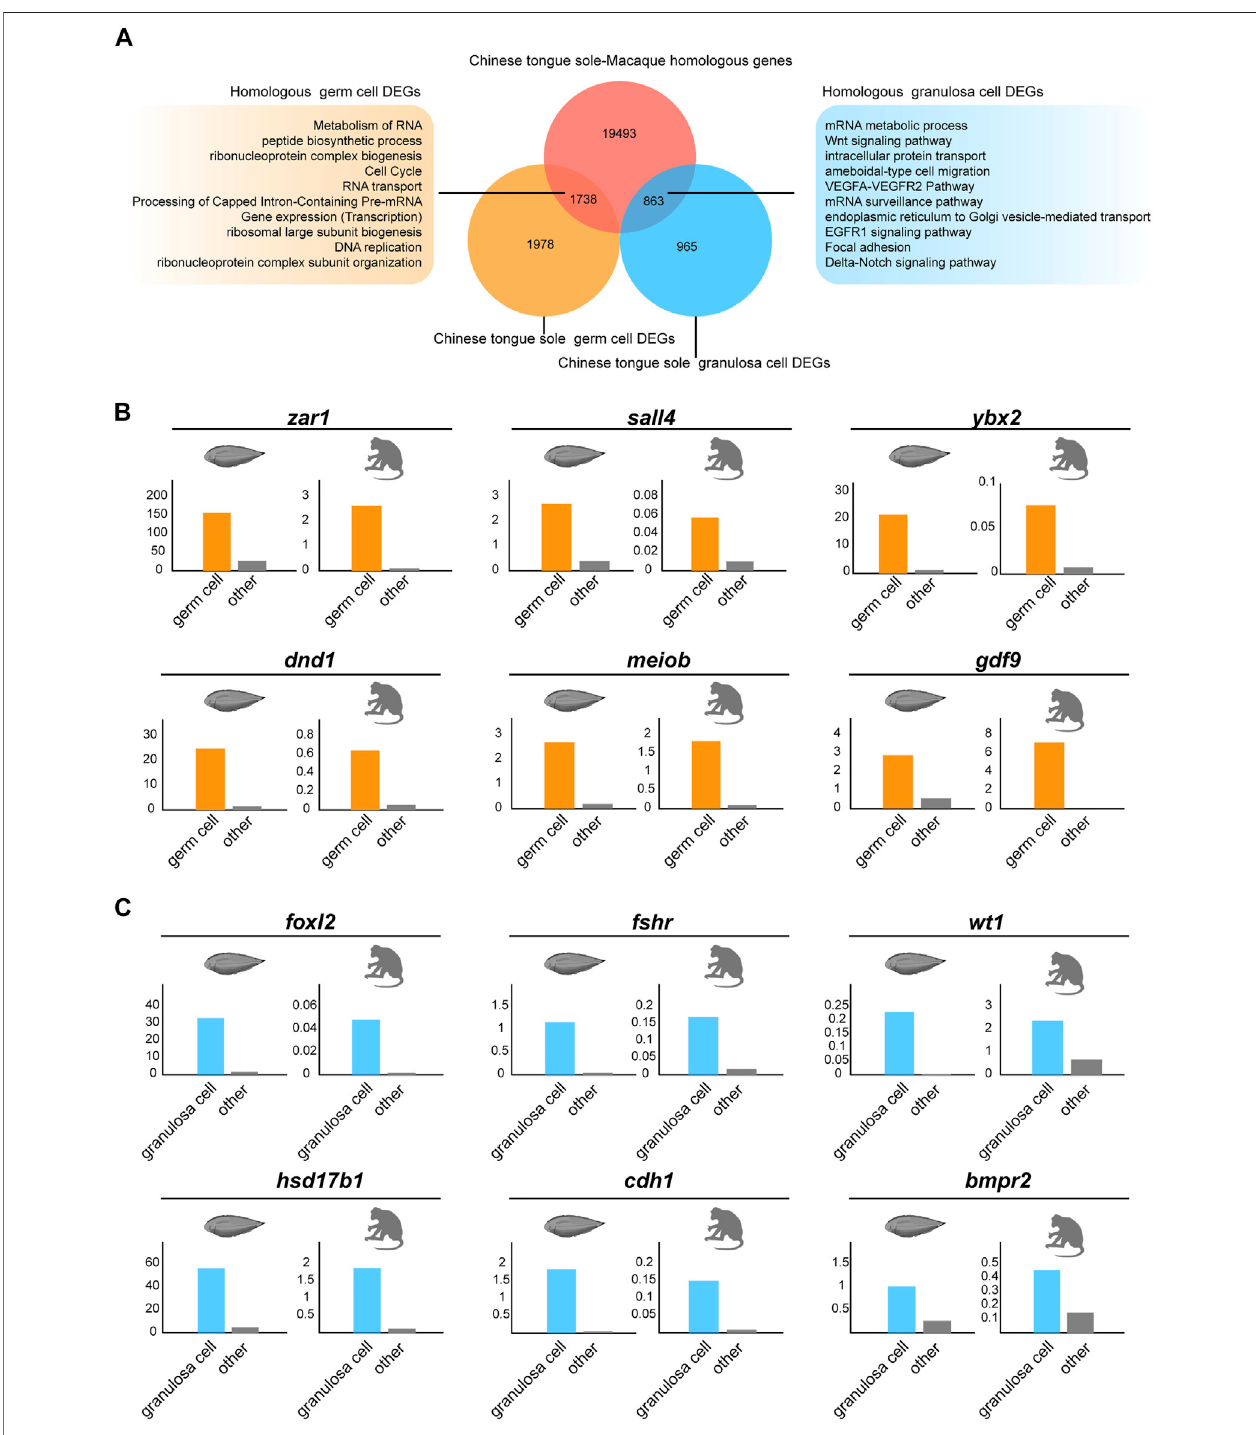
FIGURE 6 | Comparison of germ cells and granulosa cells based on Chinese tongue sole and macaque transcriptomic pro fi les. (A) Venn diagram of DEGs in the germ cells and granulosa cells of Chinese tongue sole showing overlap with the Chinese tongue sole-macaque homologous genes (light red). The enriched terms of the homologous DEGs in germ cells and granulosa cells are shown. (B) Histogram ofthe normalized expression of the shared homologous genes between Chinese tongue sole and macaques related to oogenesis in germ cells relative to the average expression of the same genes in all other cell types. (C) Histogram of the normalized expression of the shared homologous genes between Chinese tongue sole and macaques related to oogenesis in granulosa cells relative to the average expression of the same genes in all other cell types.